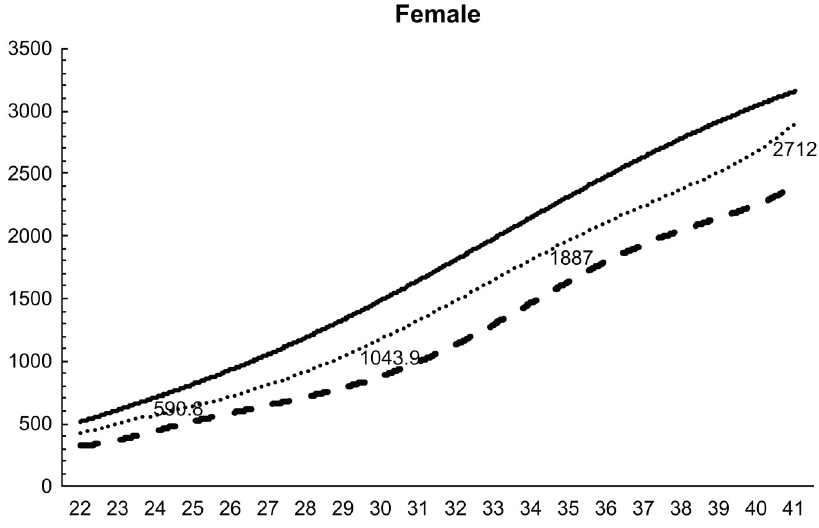
Fig 4. Birth weight reference curves for each week (female, primiparous).